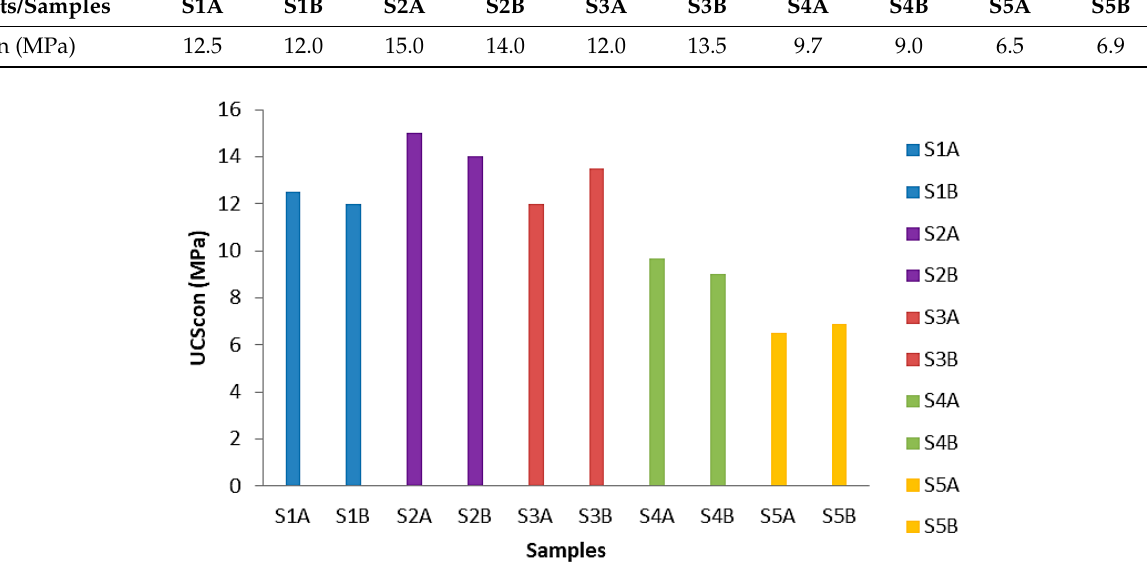
Figure 5. Uniaxial compressive strength of the tested concrete specimens (UCScon